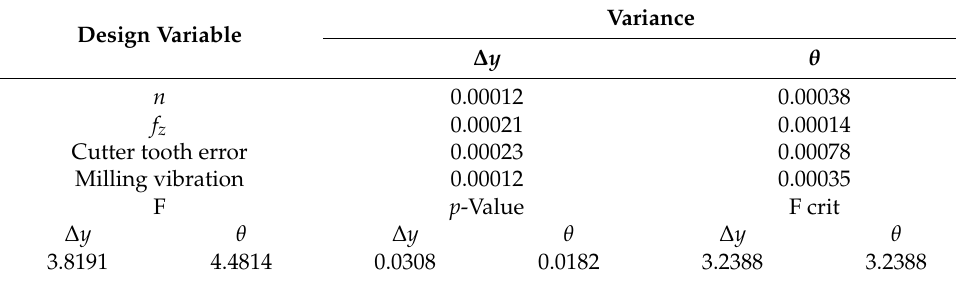
Table 4. Variance analysis results of machining error.